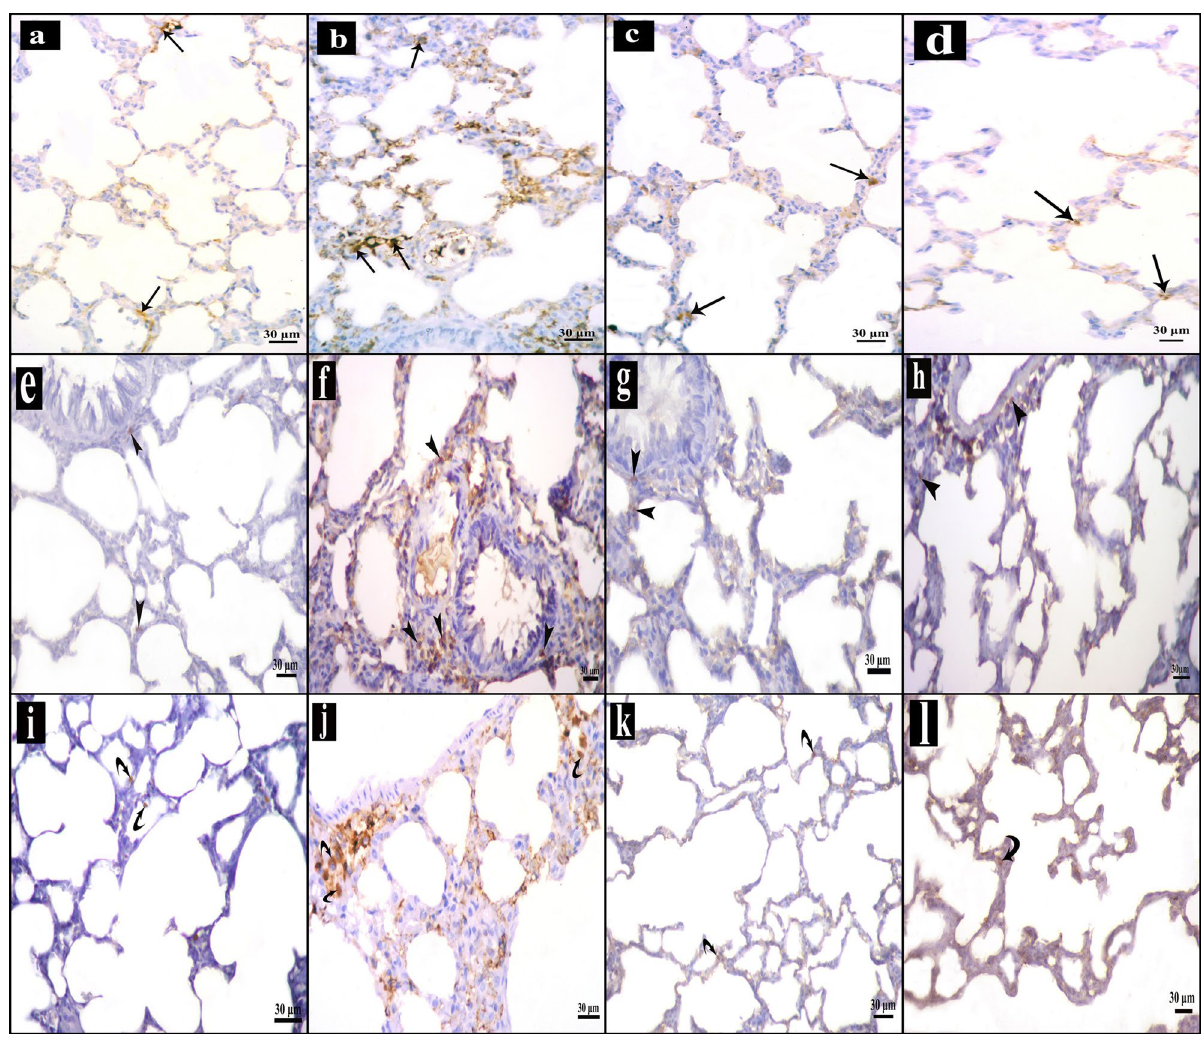
Figure 3. Immunohistochemically stained sections in lung of the study groups. (a,e,i) Control group, (b,f,j) intestinal I–R group and (c,g,k) Mesna I group. (d,h,l) Mesna II group. ( a–d) Brown cytoplasmic immune reaction for P38 MAPK in the lung tissue (arrows). ( a) Immune reactions appear in few cells. ( b) Many immune reactive cells. ( c,d) Reactions are still present in few cells. ( e–h) HSP 70 immune stained sections. ( e) Scanty positive cytoplasmic immune reactions (arrow heads) in the alveolar and bronchiolar wall. ( f) Numerous immune stained cells. ( g,h) The immunoreaction is decreased in comparison to that of the intestinal I–R